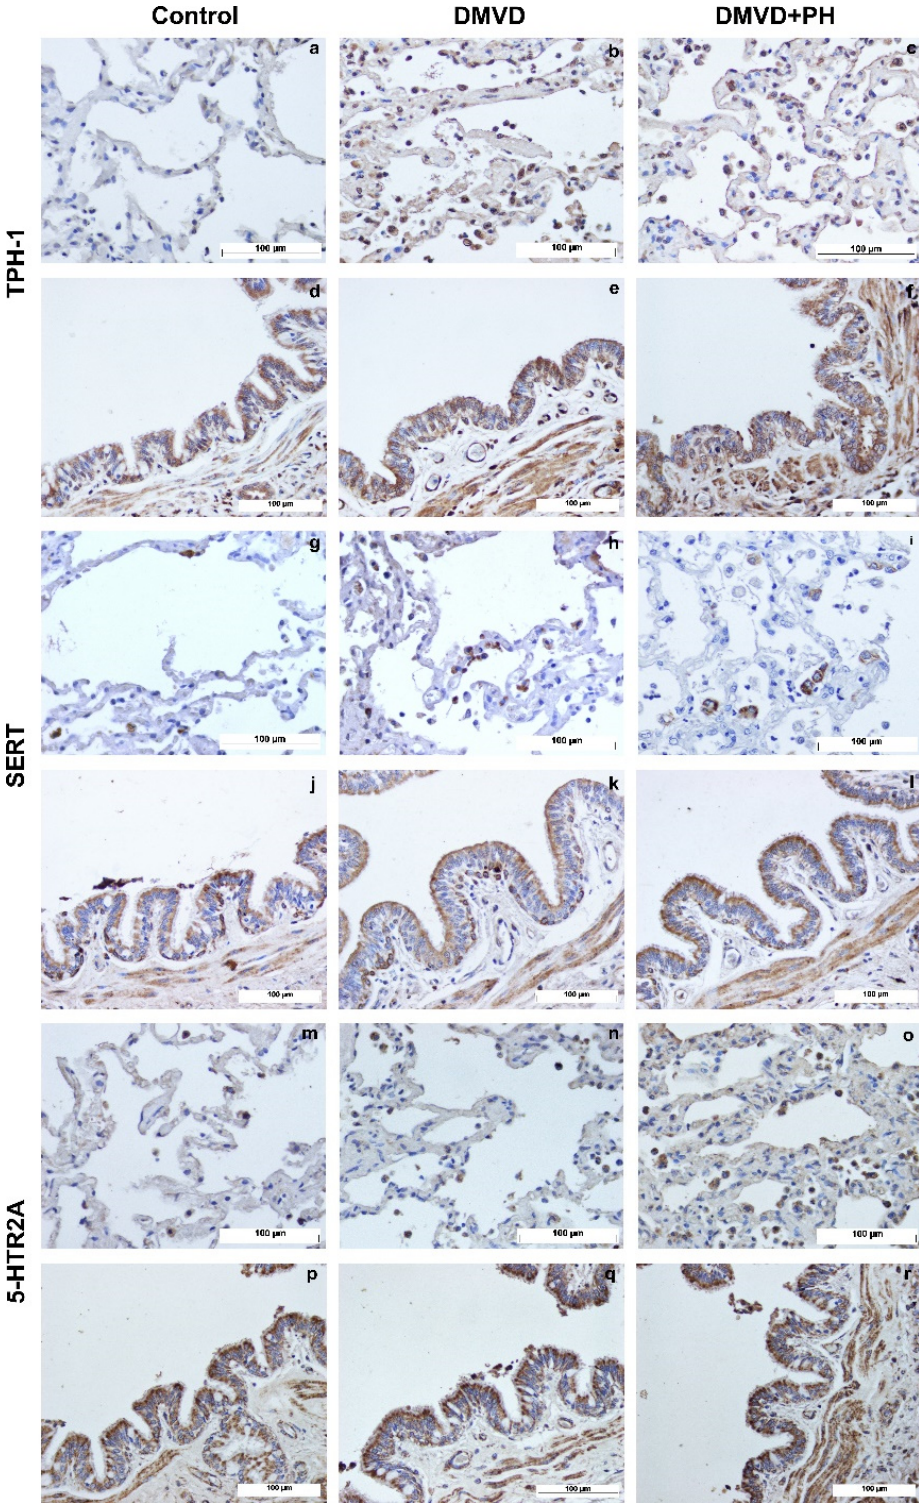
Figure 2. The cytoplasmic expression of TPH-1, SERT and 5-HTR2A in pneumocytes of alveoli PAMs (top row) and bronchial epithelial cells (bottom row) of dogs in the control ( a , d , g , j , m , p ), degenerative mitral valve disease (DMVD) ( b , e , h , k , n , q ) and degenerative mitral valve disease with pulmonary hypertension (DMVD with PH) groups ( c , f , i , l , o , r ) presented as brown color (Labeled